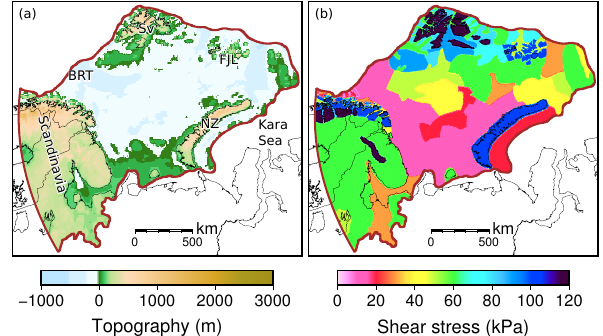
Figure 2. Basal topography used in the resolution test, which is modern topography minus the 133m drop in global mean sea level at 20ka. Also shown in brown is the 20ka ice margin (Hughes et al., 2016) and the location of places described in the text. Sv –